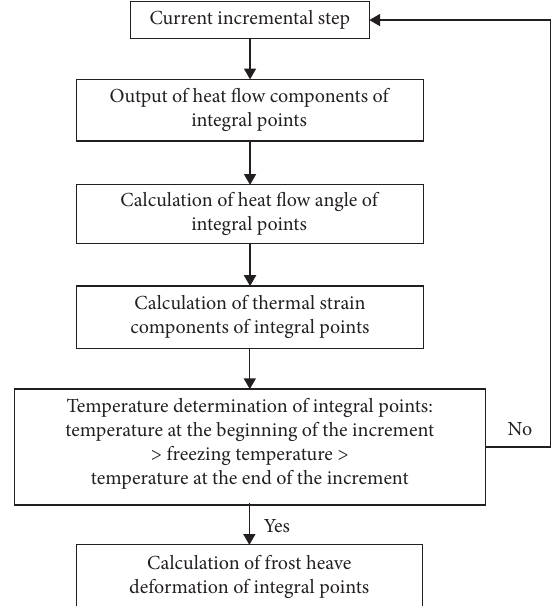
Figure 2: Flowchart of the user-defined